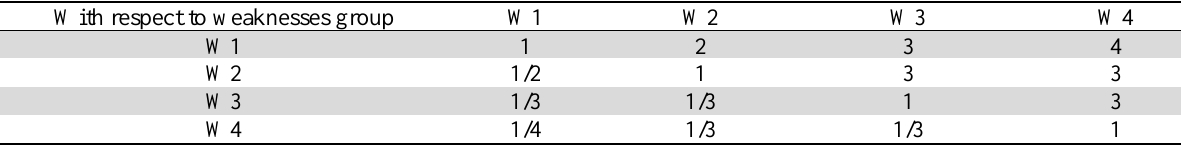
Priorities of weaknesses criteria (CR = 3.3%) With respect to weaknesses group